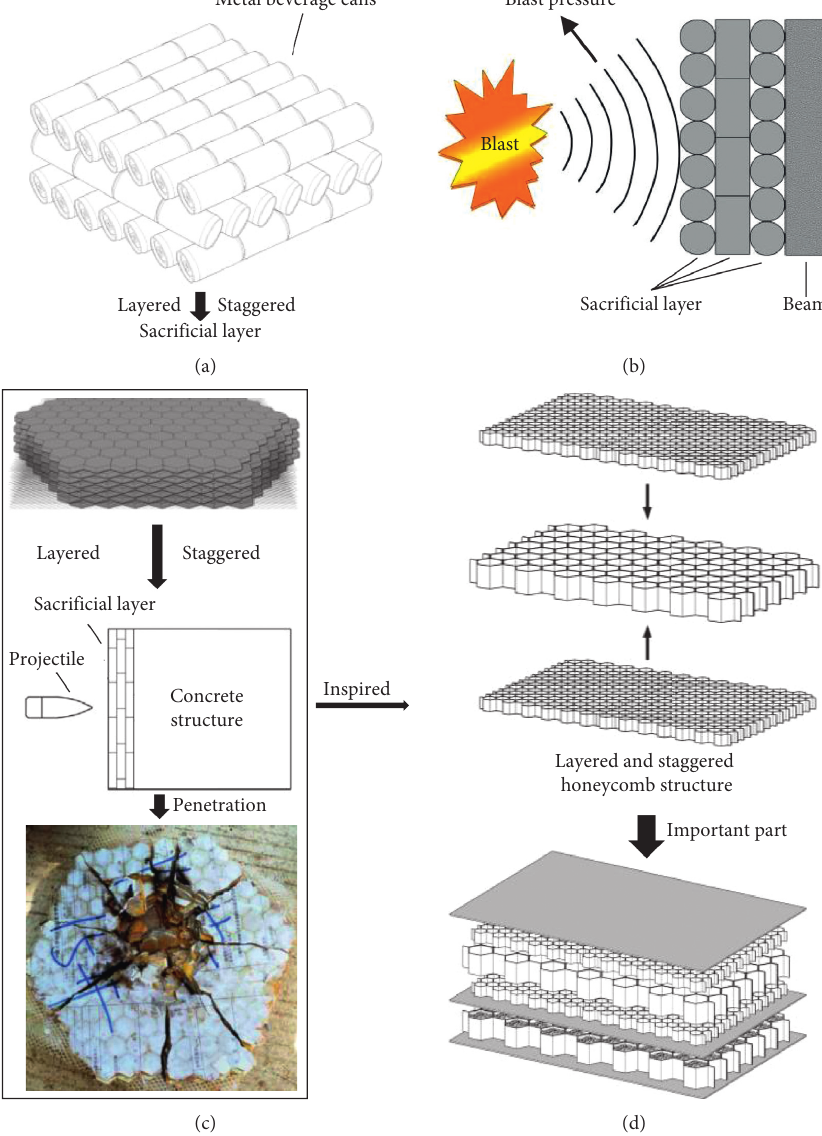
Figure 3: Design plans for sacrificial layer